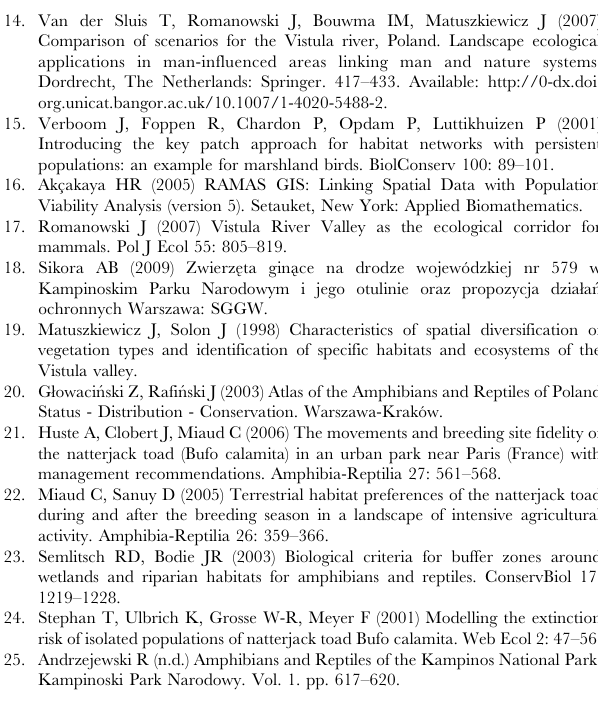
Table S1 (A) Parameterisation summary based on the ODD protocol and new protocol for PVA. (B) Parameters of the metapopulation model. Table S2 Results from sensitivity analysis of predicted metapopulation structure. Table S3 Results from sensitivity analysis of predicted carrying capacity. Table S4 Results from sensitivity analysis of expected minimum